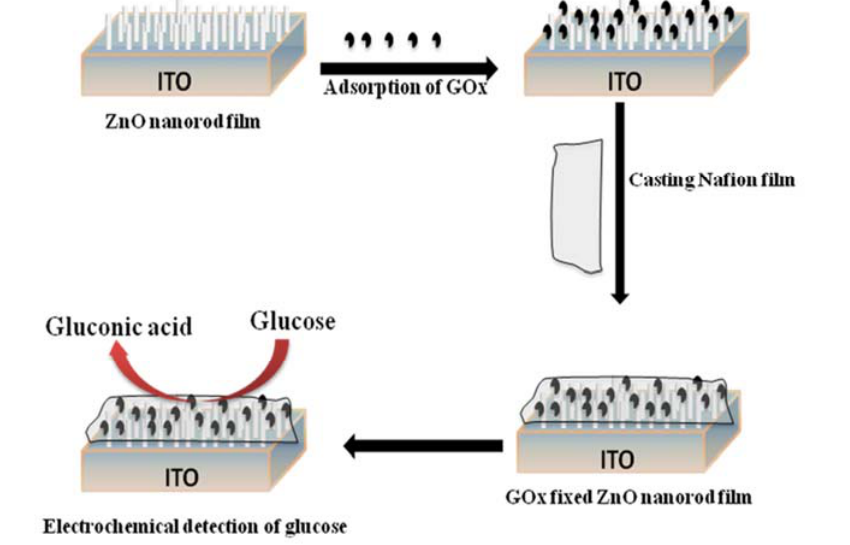
Figure 3. Schematic illustration of the preparation of the third generation amperometric glucose sensor based on the GOx-immobilized aligned ZnO nanorod (redrawn from reference